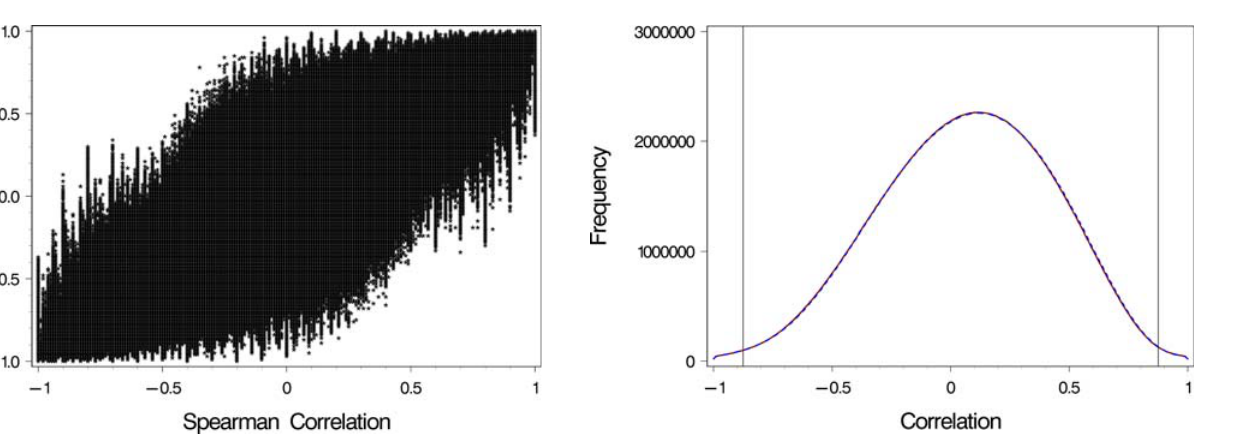
Figure 1. Comparison of Pearson’s and Spearman’s Correlation Coefficients DOI: 10.1371/journal.pcbi.0020089.g001